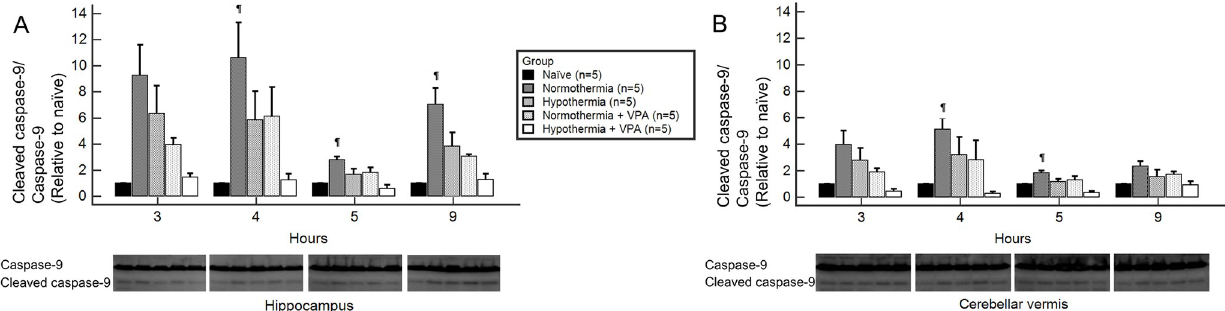
Fig 5. HSP70 of regional brain homogenates obtained at 3, 4, 5, and 9 hours after ROSC by Western blot analysis. At five hours after ROSC, the normothermic group showed significantly higher HSP70 levels than the hypotherma group both in the hippocampus (A) and the cerebellar vermis (B). HSP70 expression was significantly higher in the hypothermia + VPA group than in the hypothermia group in both regions. Bars represent mean ± SEM. Intergroup comparison was performed by one-way analysis of variances with Scheffe´ post-hoc analysis. # , p < 0.05 versus hypothermia; ¶ , p < 0.05 versus hypothermia +